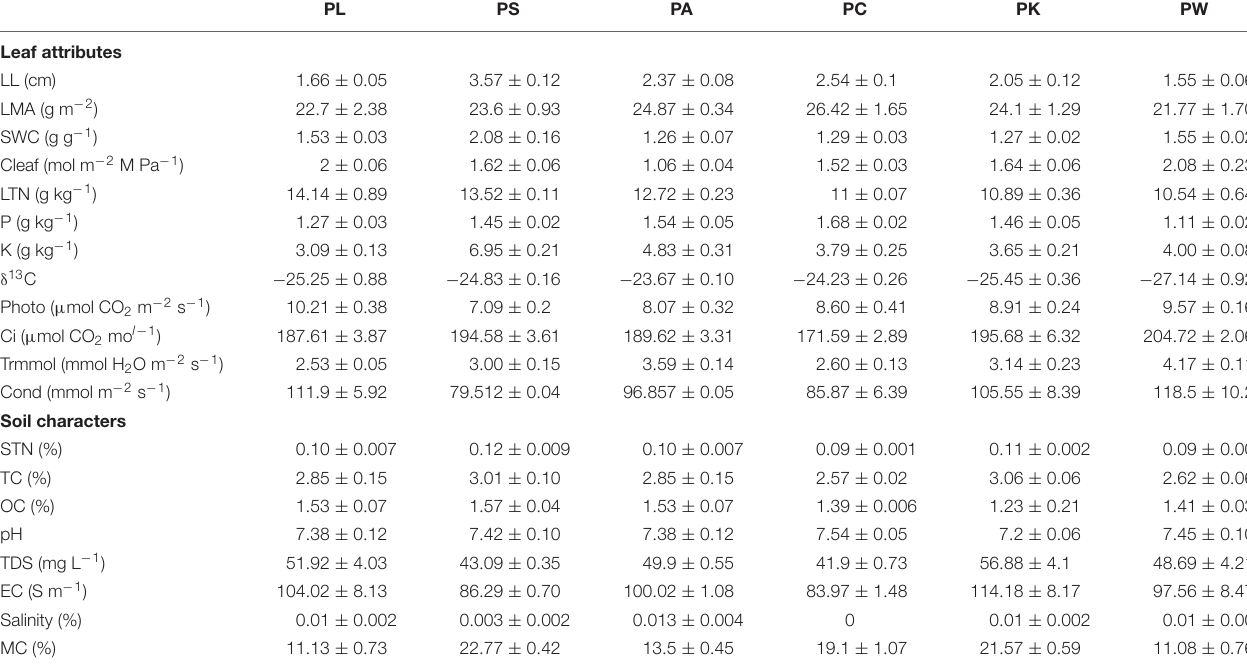
TABLE 1 | Host attributes information of the six tree species and near-root soil characters used in this study. PL PS PA PC PK